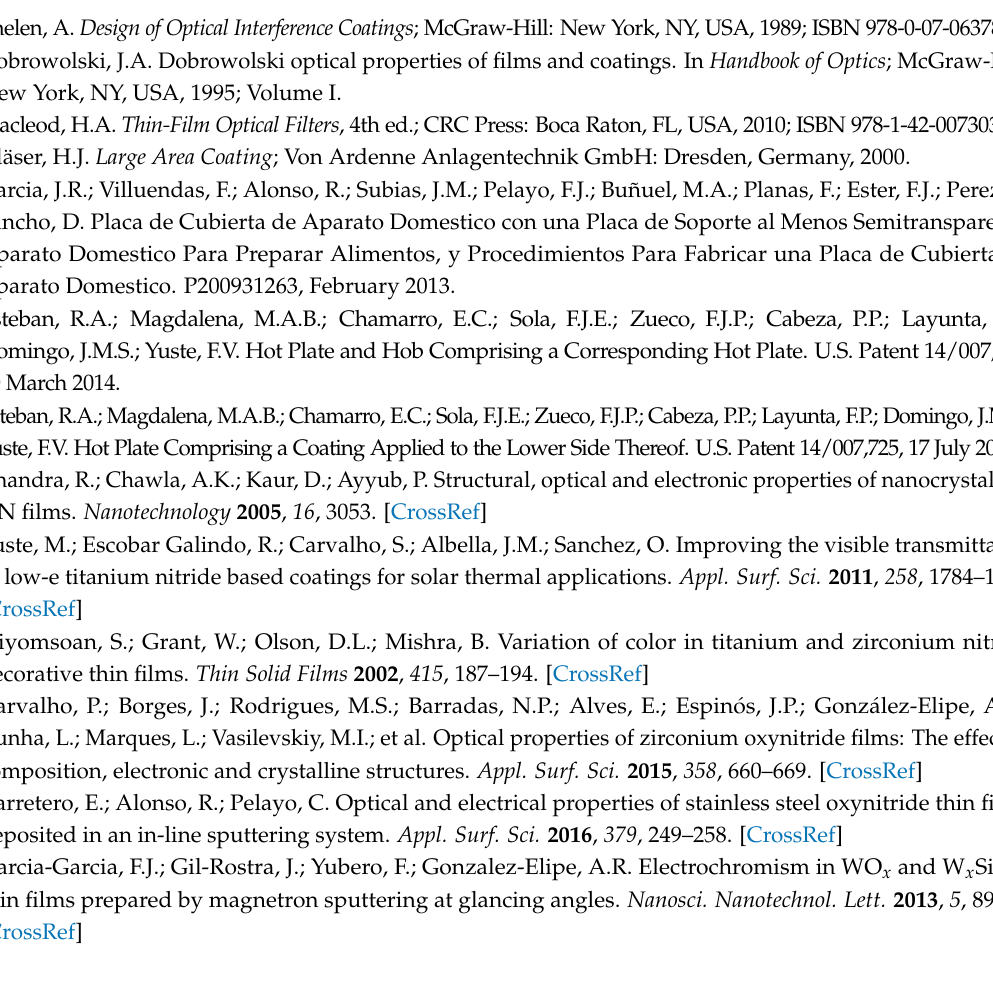
Figure S1: Complex refractive indexes of Sst, Figure S2: Refractive indexes of SiAlN x , Figure S3: Refractive indexes of SnO 2